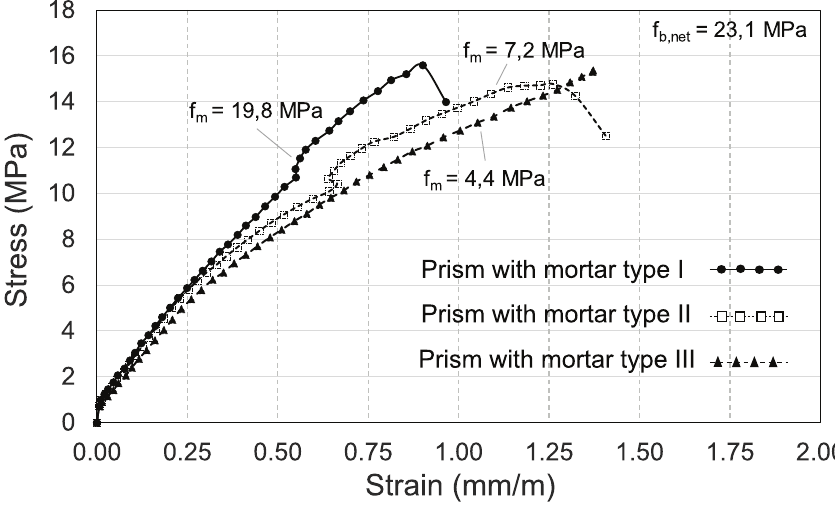
Masonry stress-strain for three mortar